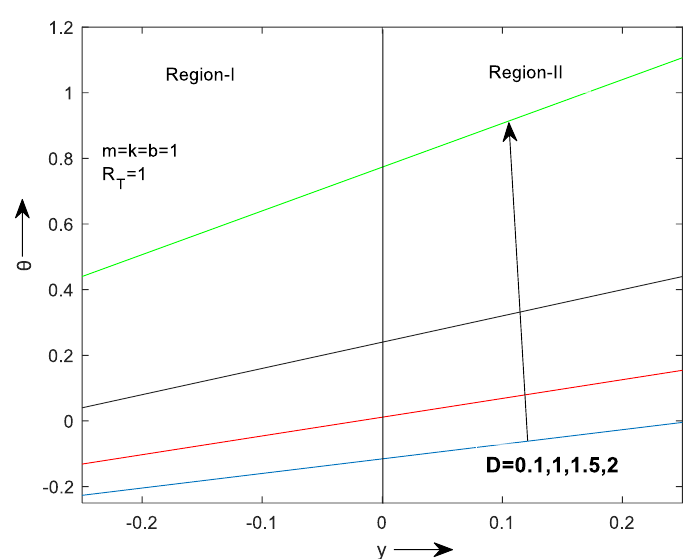
Fig. 6b. Temperature profile for different values of